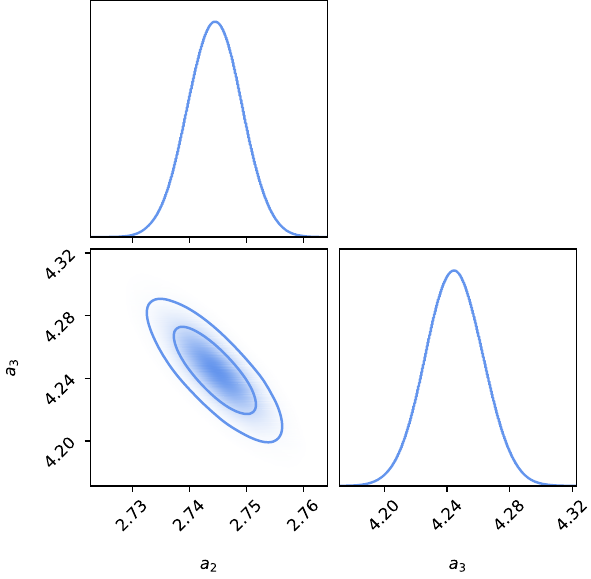
Fig. 3 Marginalized constraints on a 2 and a 3 based on the standard sirens catalog from the DECIGO